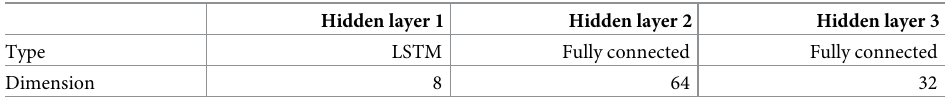
Table 1. The neural network architecture for the proposed